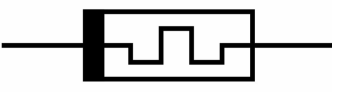
Figure 1. Electronic symbol of the